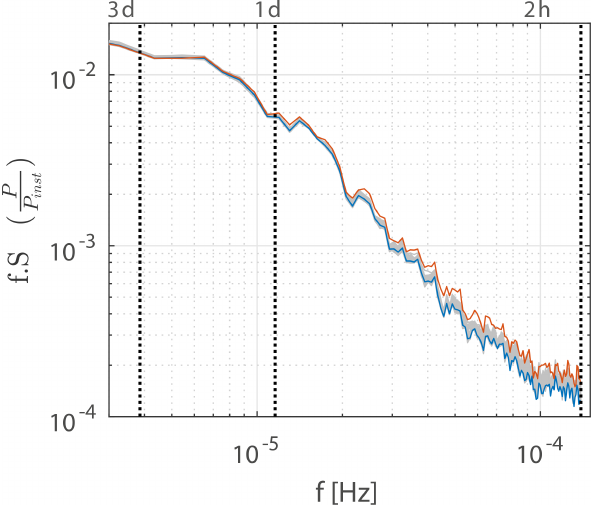
Figure 6. PSD for various optimized combinations of lumped hourly wind power output time series per installed capacity ( P Blue line: Case I. Red line: Case II. Gray lines (66 compressed lines): PSD for all 66 possible combinations of 12 lumped power output time series, with the constraint that 2 of the 12 sites are lo- cated on the southernmost islands.